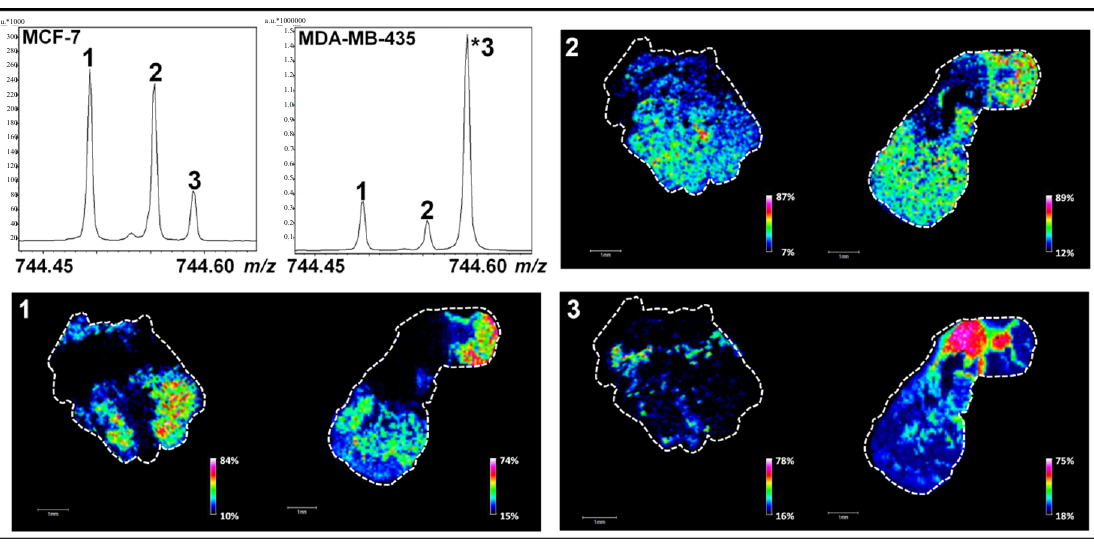
Figure 4. MALDI MSI analyses of MCF-7 (to the left) and MDA-MB-435 (to the right) tumor sections in narrowband mode. Associated ion images represent the localization of low-abundant PLs with m/z 744.49419 (peak 1), m/z 744.55385 (peak 2) and m/z 744.59019 (peak 3). PL relative contents determined by LC-ESI-MS are available in Table S3 (scale bars, 1 mm).